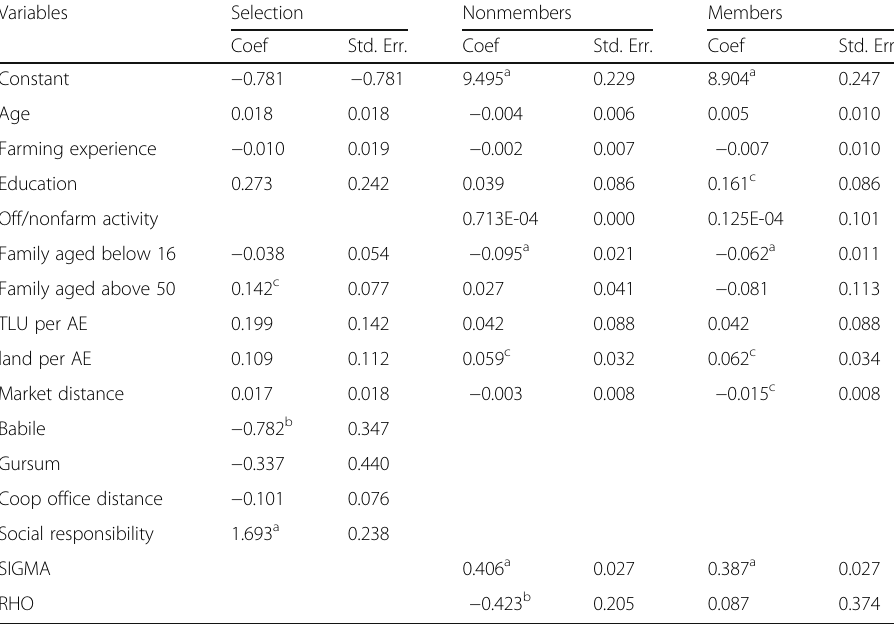
Table 4 Full information maximum likelihood estimates of the switching regression model Variables Selection Nonmembers Members Coef Std.